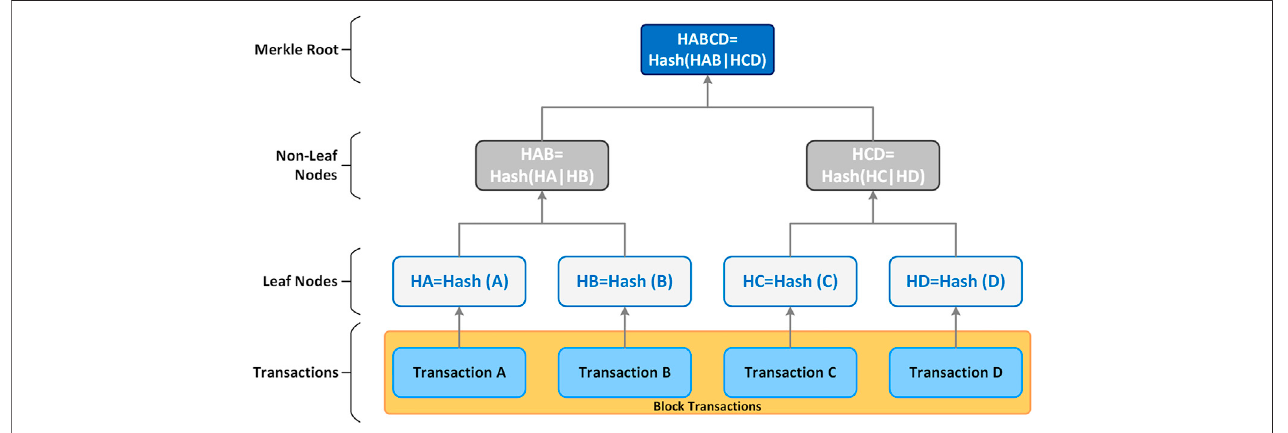
FIGURE 7 | A simple Merkle